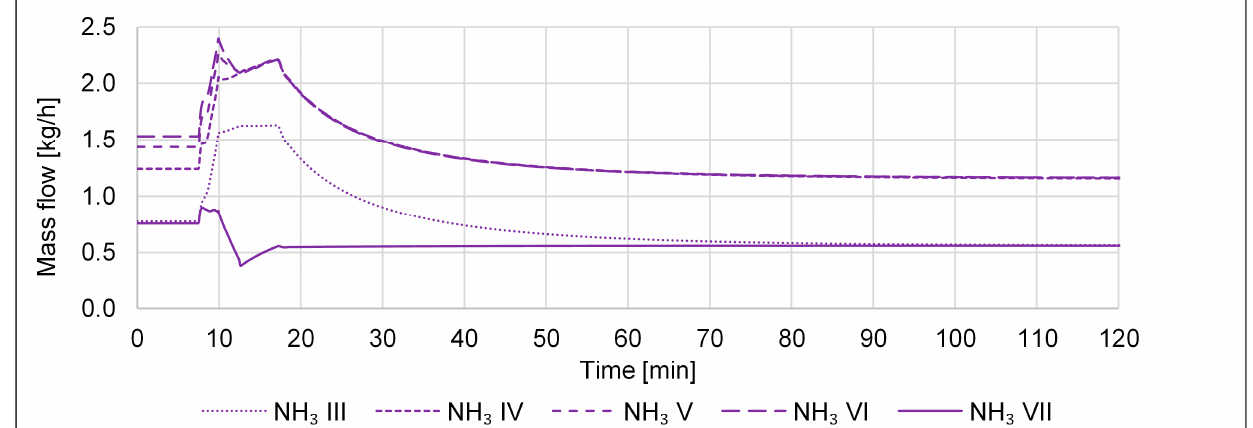
Figure 25 . Selected NH3 mass fl ows of scenario (i). Figure 25. Selected NH3 mass flows of scenario